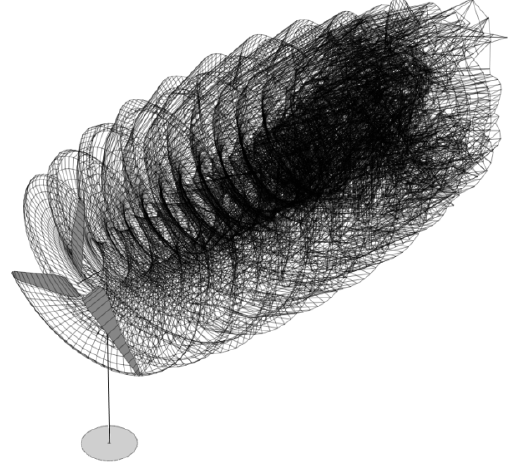
Figure 5. Snapshot of the LLFVW simulation after four rotor rev-